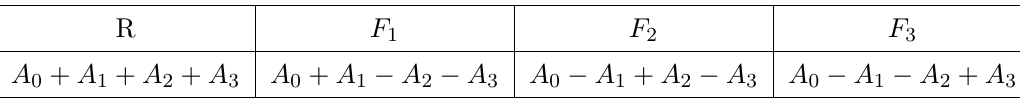
Table 4. Bulk gauge field duals to the UV